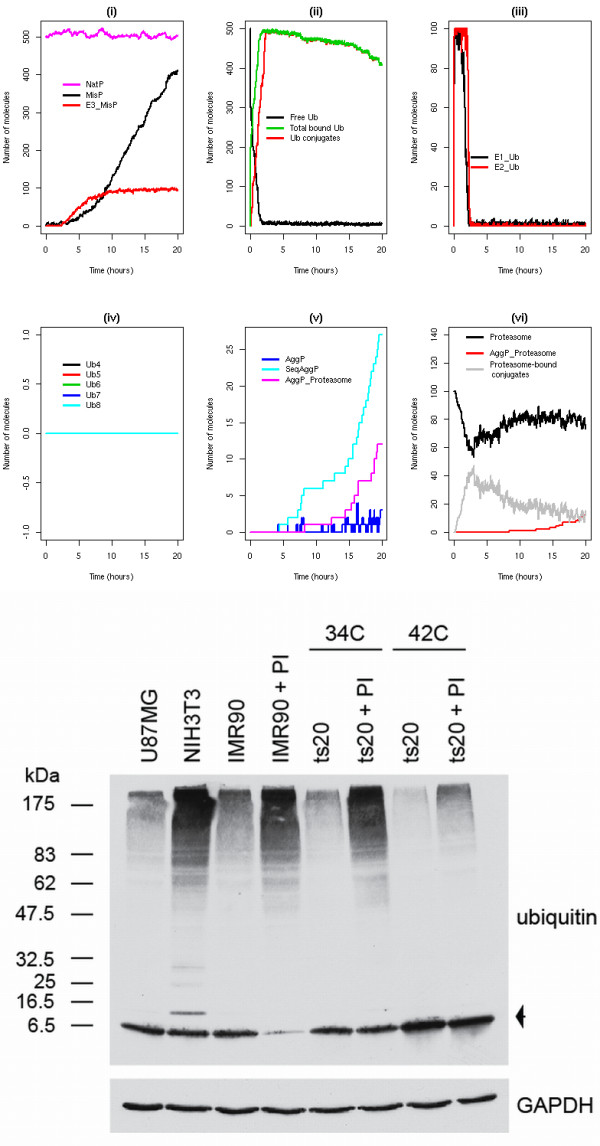
Inhibiting proteasome activity. Results are shown for a typical simulation, for a 20 hour period (a) Model output (k69 = 0, all other parameters as in Tables 2 and 3). (i) Level of native protein (NatP), misfolded protein (MisP), and misfolded protein bound to E3 (E3_MisP). (ii) Ubiquitin pools. (iii) Ubiquitin bound to E1 and E2 (E1_Ub and E2_Ub respectively). (iv) Cumulative number of degradation reactions for different length of ubiquitin chains bound to substrate. (v) Accumulation of aggregated protein (AggP), sequestered aggregated protein (SeqAggP) and aggregated protein bound to proteasomes (AggP_Proteasome). (vi) Available pool of proteasomes, number of proteasomes bound by substrates and number of proteasomes bound by aggregated proteins. (b) Survey of ubiquitin pools in various cell lines. Western blot analysis of cell extracts from U87MG, NIH-3T3, IMR90 and ts20 cells with an antibody raised against ubiquitin. The pool of conjugated ubiquitin (vertical line) was found to differ between cell lines with the highest levels detected in NIH-3T3 cells. Comparable levels of conjugated ubiquitin were detected in IMR90, U87MG and ts20 cells cultured at 34°C. ts20 cells cultured at 42°C for 3 hours had the least detectable levels of poly-ubiquitinated conjugates. Whereas a shift from monomeric (arrowhead) to conjugated ubiquitin (vertical line) was observed in IMR90 cells treated with proteasome inhibitor for 3 hours, no difference in the pool of monomeric ubiquitin was observed in ts20 cells treated with the inhibitor. The membrane was re-probed with an antibody directed against GAPDH which served as a loading control (boxed panel).